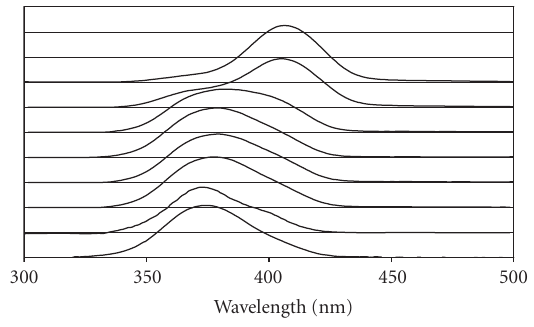
Figure 6: Derivatives obtained from UV-Vis/DR spectra of model mixtures of anatase and rutile. From bottom to top: 100% rutile, 90% rutile + 10% anatase, 80% rutile + 20% anatase, 70% rutile